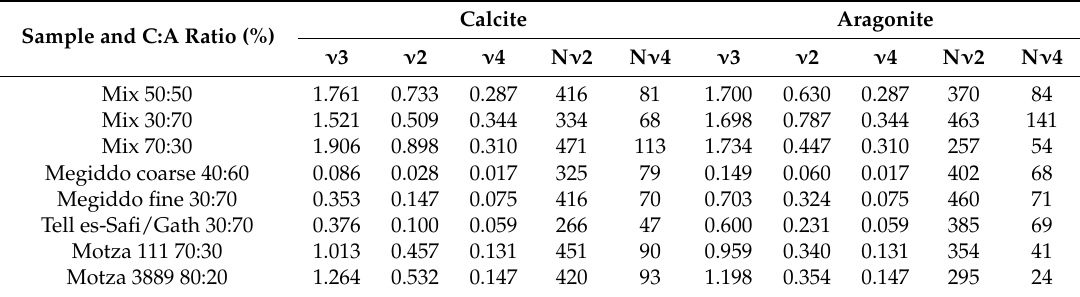
Figure 4. FTIR spectrum of a 50:50 mixture of calcite spar and aragonite spar, showing the location of the respective absorptions (a.u.: arbitrary units). Table 1. Intensity values and normalized heights for calcite and aragonite in mixed polymorph samples (C: calcite; A: aragonite; N: normalized). The quantification of archaeological samples (C:A ratio) is based on XRD.